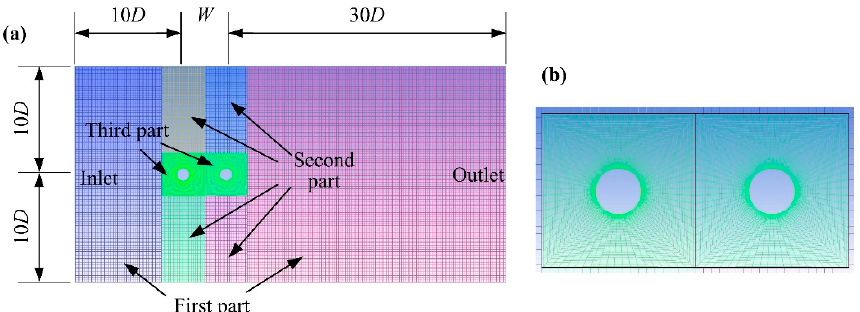
Figure 3. Schematic of the flow field grid of the tandem arrangement of energy harvesting system: ( a ) grid diagram of flow field; ( b ) partial grid diagram of third part.